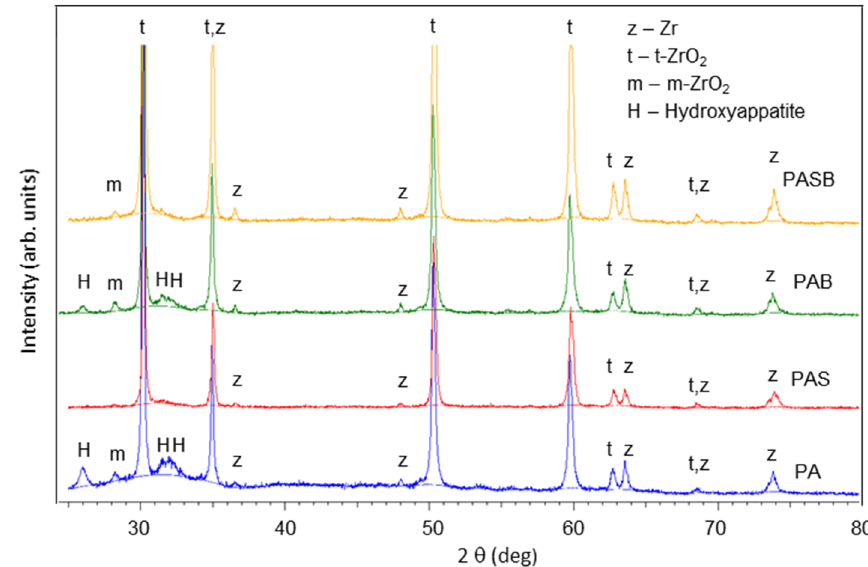
Figure 6. X-ray diffractogram of the PA, PAS, PAB, PASB-coatings after the SBF test. Table 7. Evaluation of the crystalline phases content (wt.%) in PEO coatings after the SBF test by the X-ray diffraction analysis.